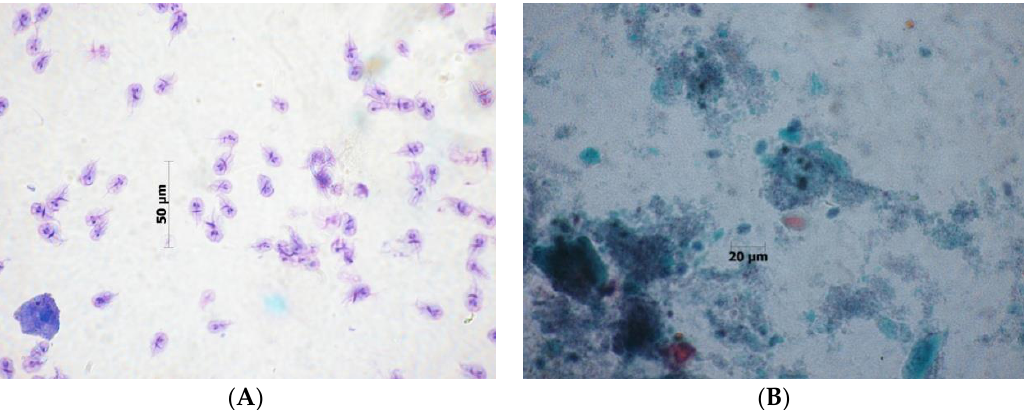
Figure 5. ( A ) Giardia sp. trophozoite forms at 40x. ( B ) Giardia sp. cyst forms at 40x (all original photography).